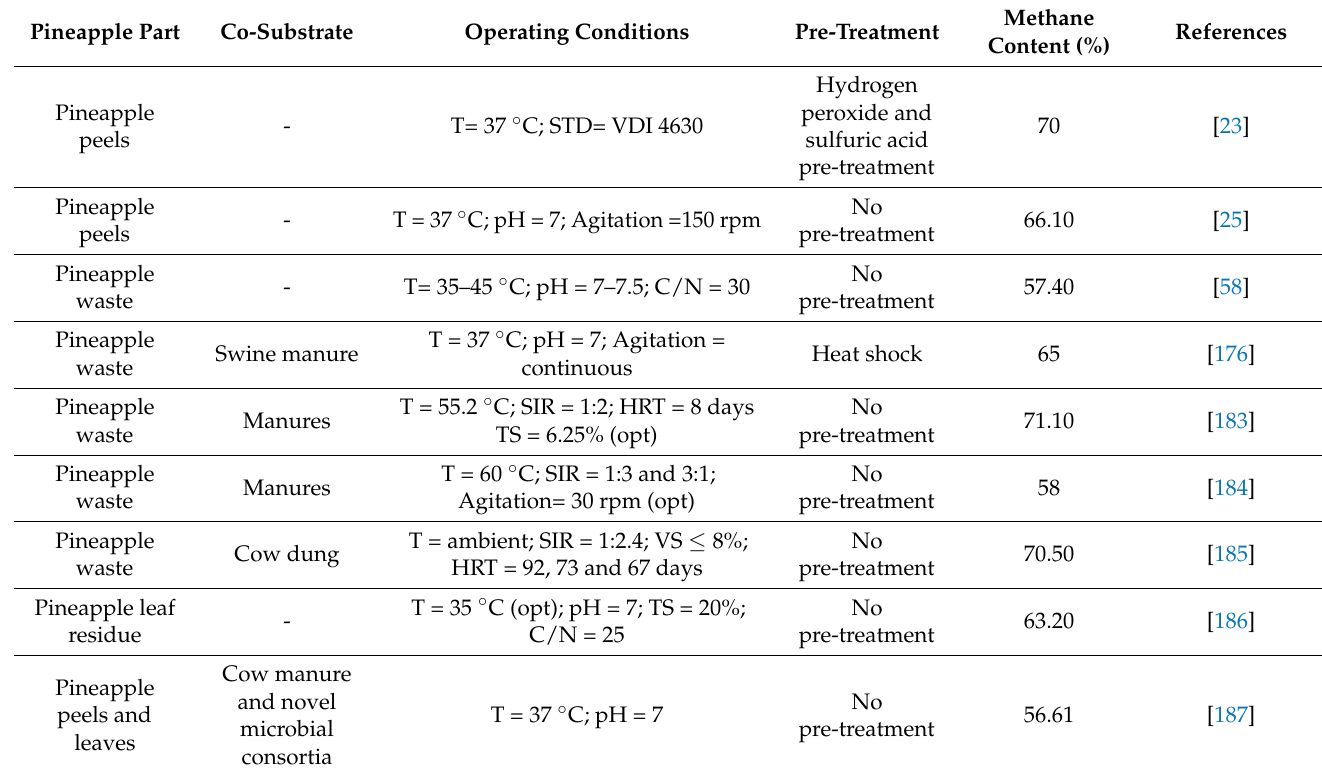
Table 6. Previous research works on methane production from pineapple